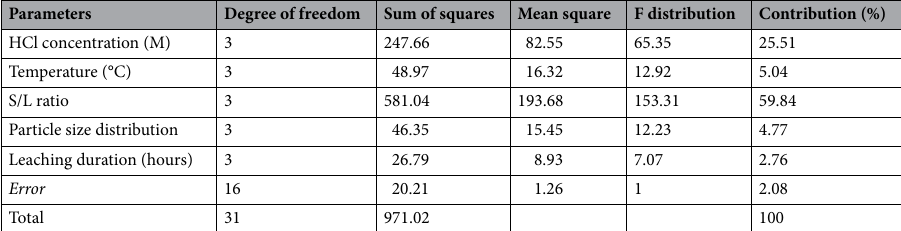
Table 7. Result of the analysis of variance for the dissolution of titanium.